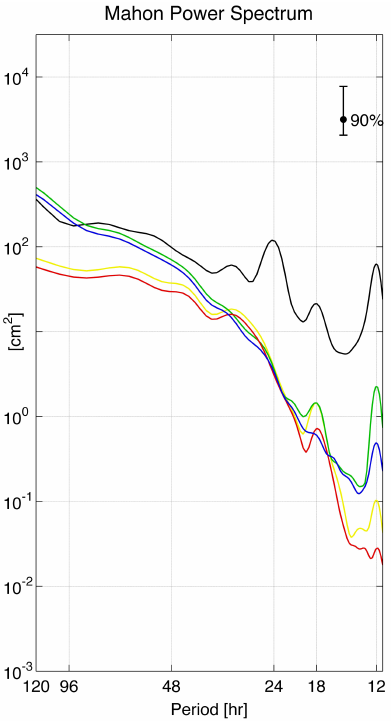
Figure 9. Mahon η power spectra from observations and model re- sults. Observations, black; NEMO-MFS1, red; NEMO-MFS2, blue; NEMO-MFS3, yellow; NEMO-MFS4,